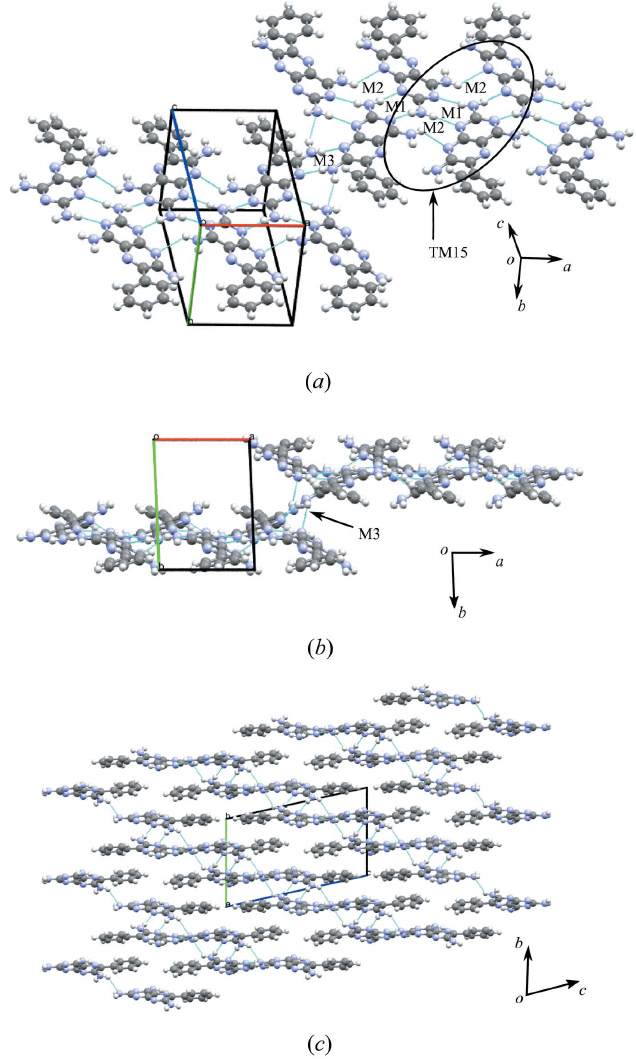
Figure 3 ( a ) Motifs M2, M1 and M2 (tape motif TM15) and motif M3 observed in 1 . ( b ) The view along c illustrating the relationship between adjacent tapes using the M3 motif (side view). ( c ) Packing diagram of the stepped hydrogen-bonded